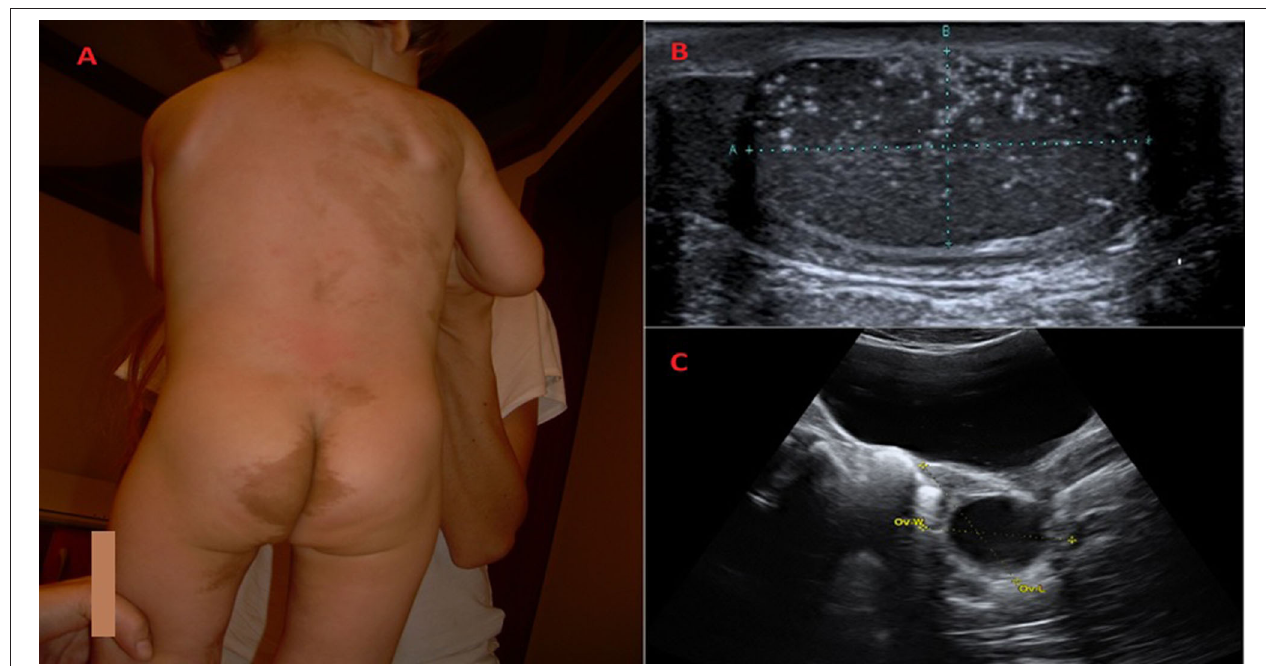
FIGURE 1 | Clinical and radiological features of children diagnosed with McCune Albright syndrome. (A) Classic Café-au-lait skin pigmented lesion in a 25-months-old boy with McCune-Albright Syndrome. The spots with smooth borders, respect the midline and follow the developmental lines of Blaschko. At follow up, fibrous dysplasia of the both tibias has been revealed. (B) When he was 3-years-old, a light testicular asymmetry has been noted and testicular microlithiasis has been revealed on ultrasound. (C) Unilateral ovarian cyst in a 7-years-old girl with vaginal bleeding diagnosed with McCune Albright